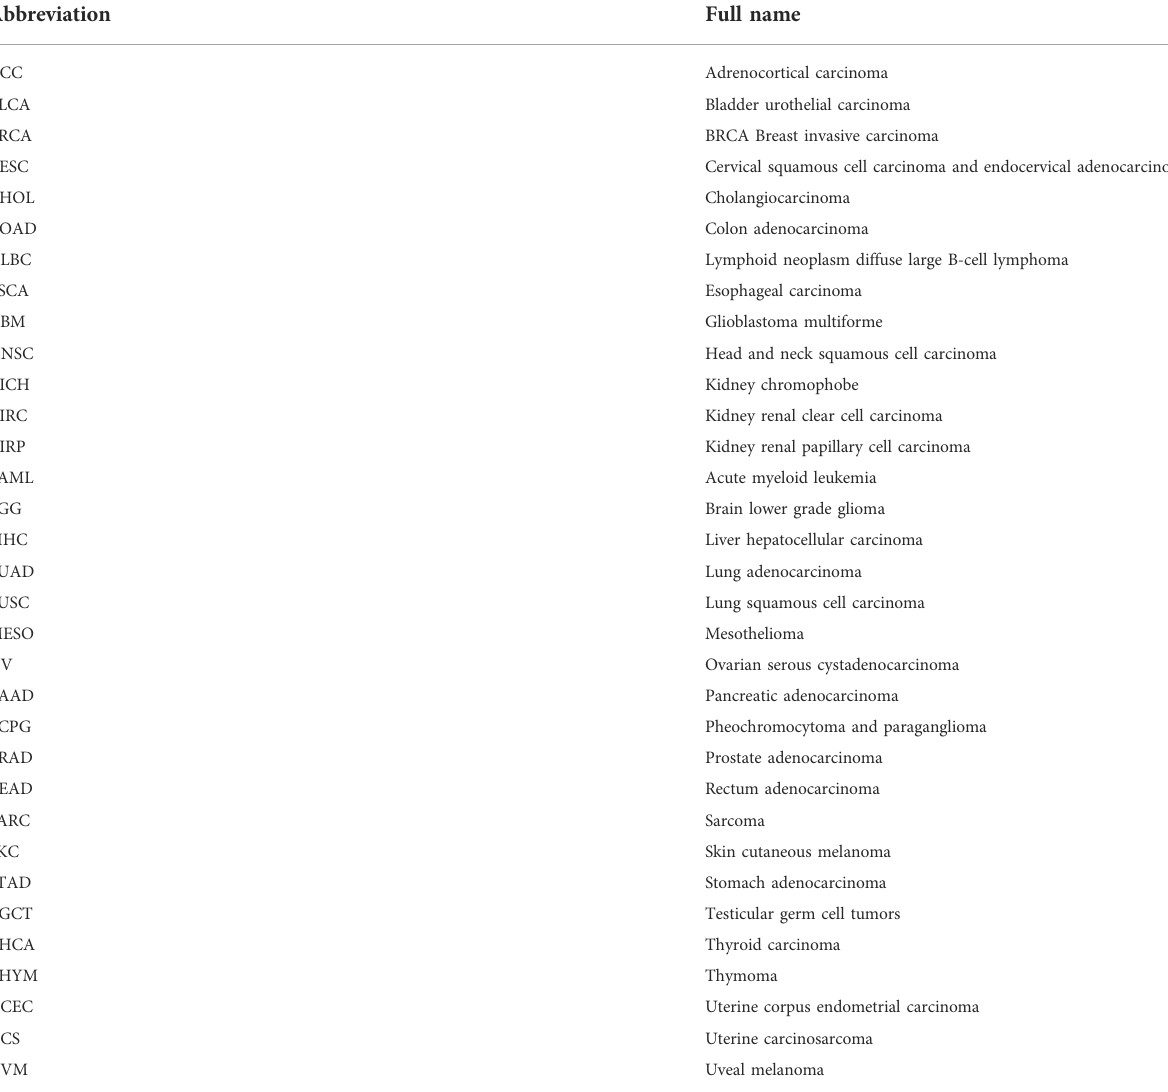
TABLE 1 33 types of human cancers employed in our